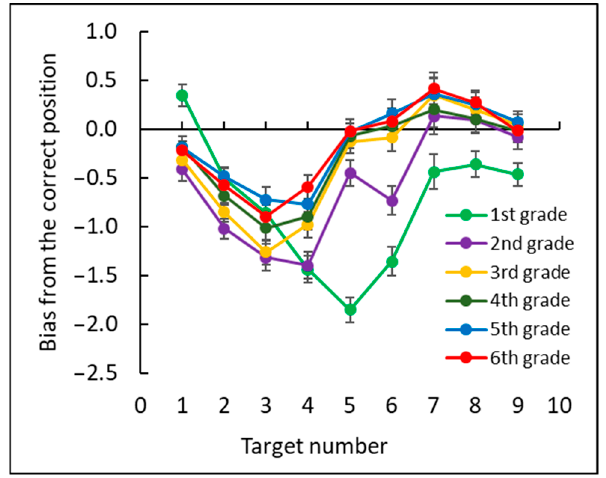
Figure 6. The mean bias value: the deviation between the estimated position of each target number and its correct position for each grade.